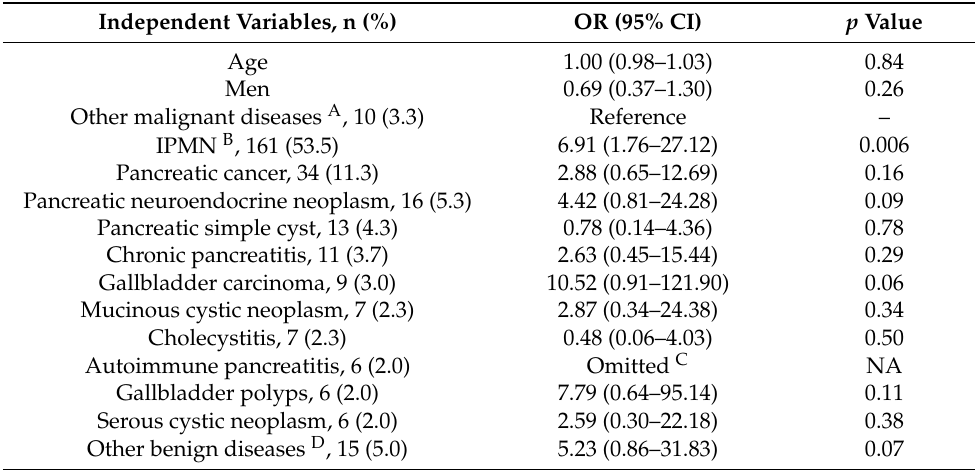
Table 4. Factors in contrast-enhanced harmonic endoscopic ultrasonography that determine corre- spondence with the final diagnosis using multivariate logistic regression analysis (n =